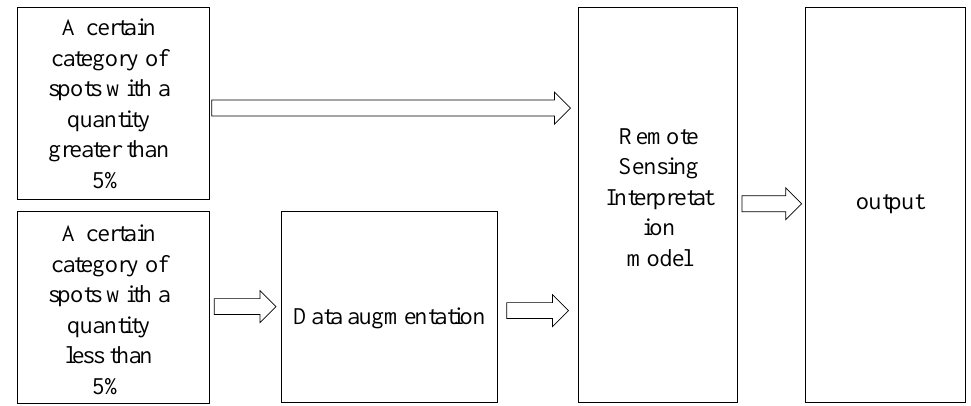
Figure 2. Remote sensing interpretation network with improved training flow